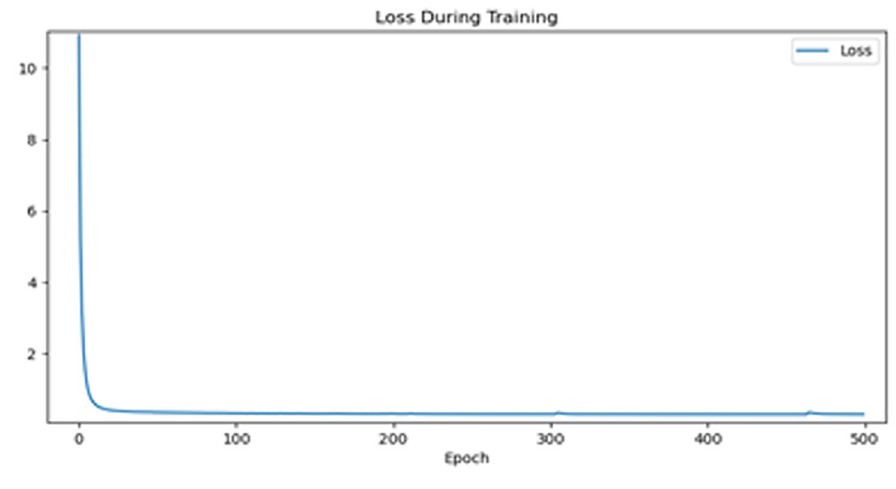
Fig 6. U-Net epoch-loss